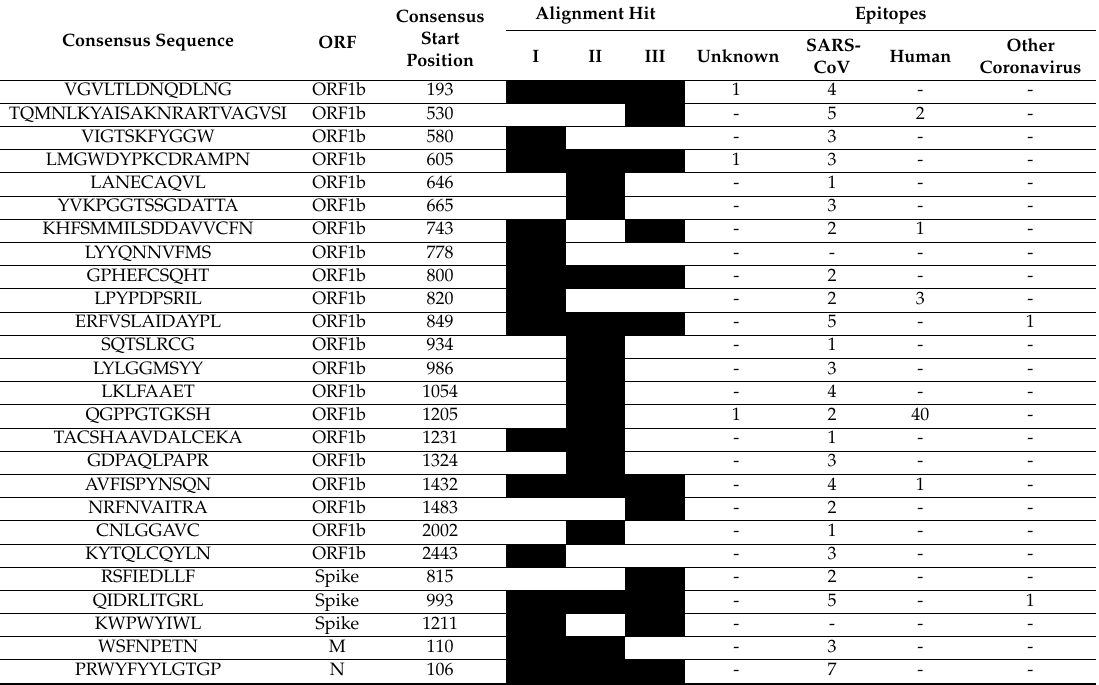
Table 3. Conserved sequences among di ff erent coronavirus. I: Pan-coronavirus, II: Betacoronavirus, III: Human coronavirus alignment. The black squares that indicted which alignments contained the conserved